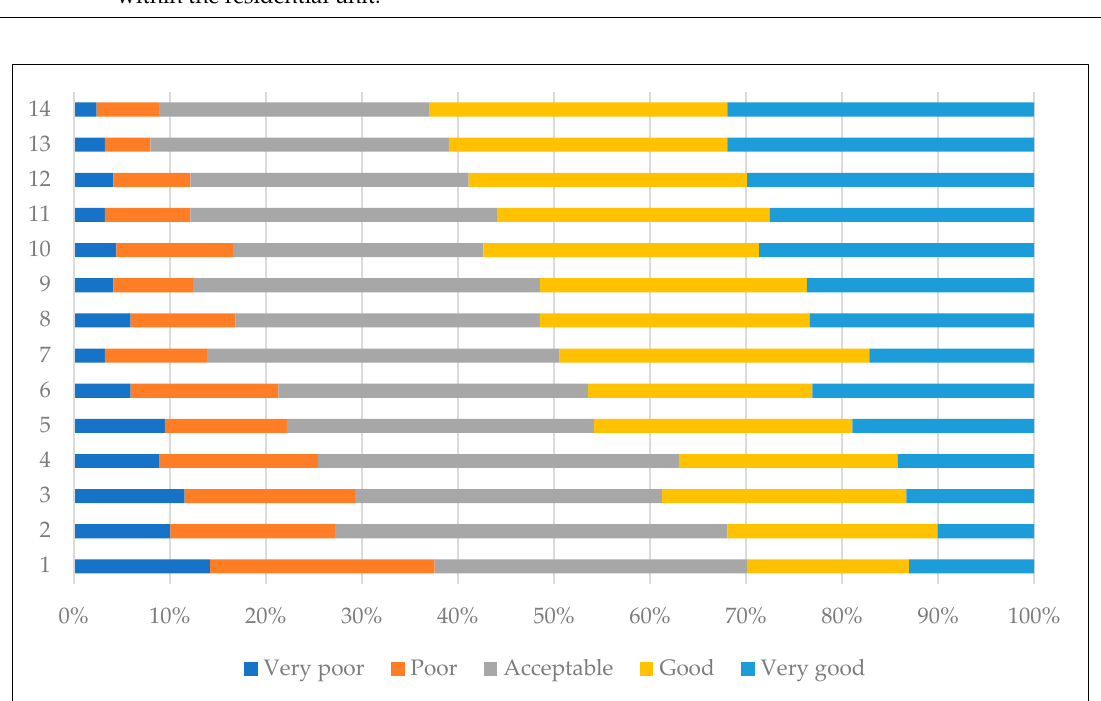
Figure 11. The participants’ views of the sufficient rooms for individual self-isolation.